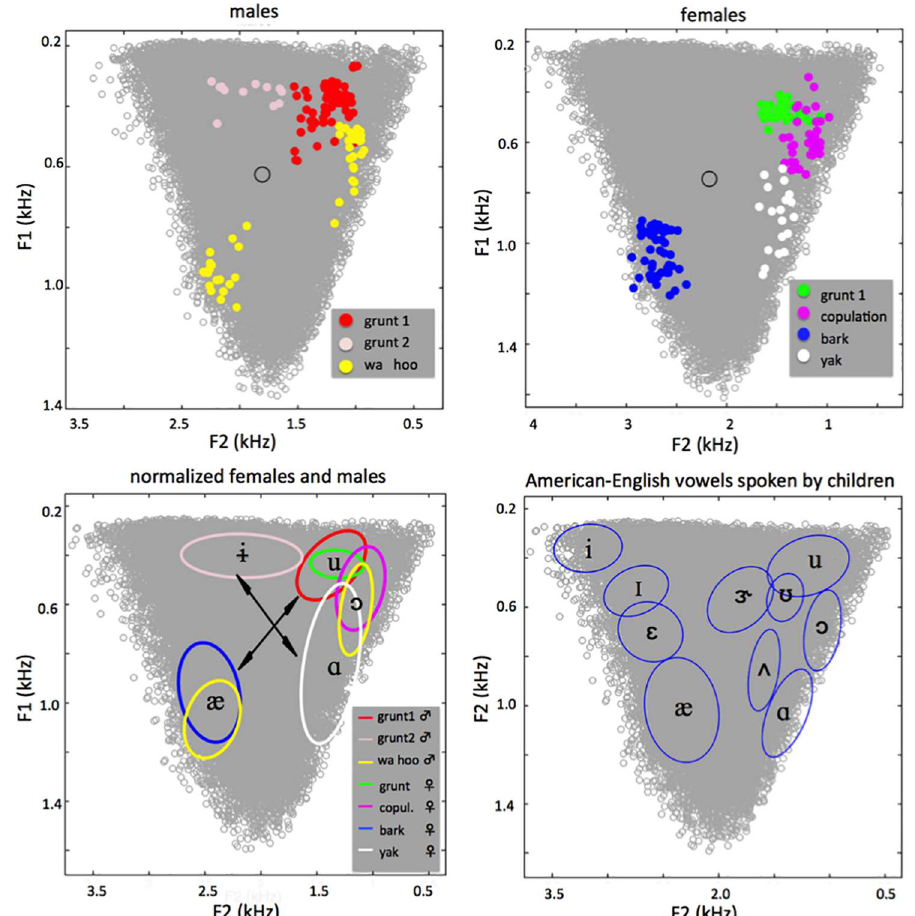
Fig 3. Distribution of VLSs within the MAS. (A) and (B) show the males’ and females’ MAS, respectively, with our data (analyzedin frames). An opencircle marks the locationwhere a neutral tube of the vocal tract’s length wouldproducethe central schwa sound, [ ə ]. (A) confirms that male grunts occur in two subtypes, grunt 1 and grunt 2, based on distinct F2 ranges. (C) shows normalized data, pooling males and females. Ellipses within the MAS delineate an area covering 86.5% of the data for each VLS category. Note that the baboons produced five distinct VLSs, [ ɨ æ ɑ ɔ u]. Comparison of the findingsto those of American-Englishspeaking children[30, data publiclyavailablein Praat] shown in (D) demonstrates strong similarities betweenthe two species,suggestinga phylogenetically ancient origin of the vowel systems of humans. Arrows indicate